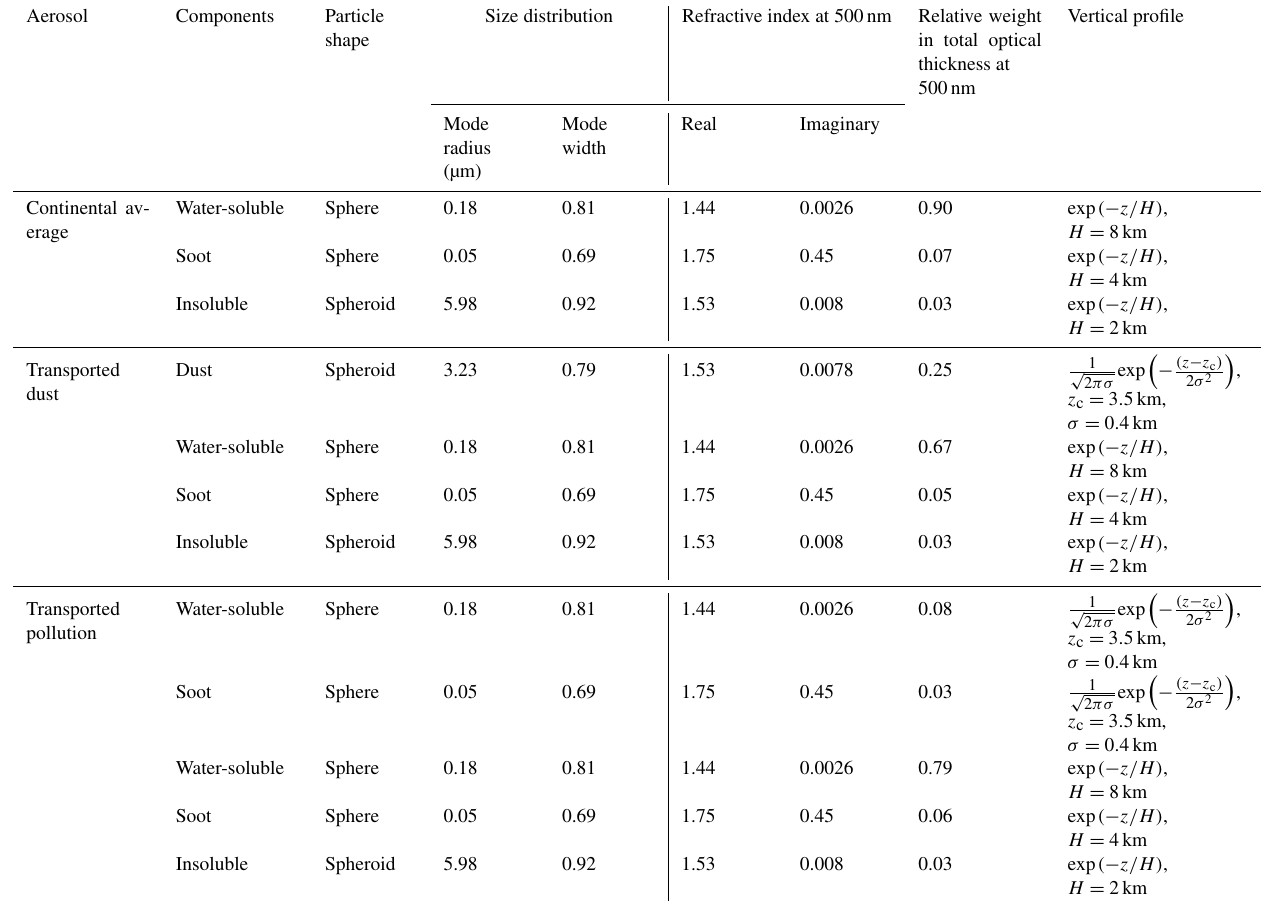
Table 1. Microphysical and optical properties and vertical profiles of the aerosols used in the sensitivity tests.